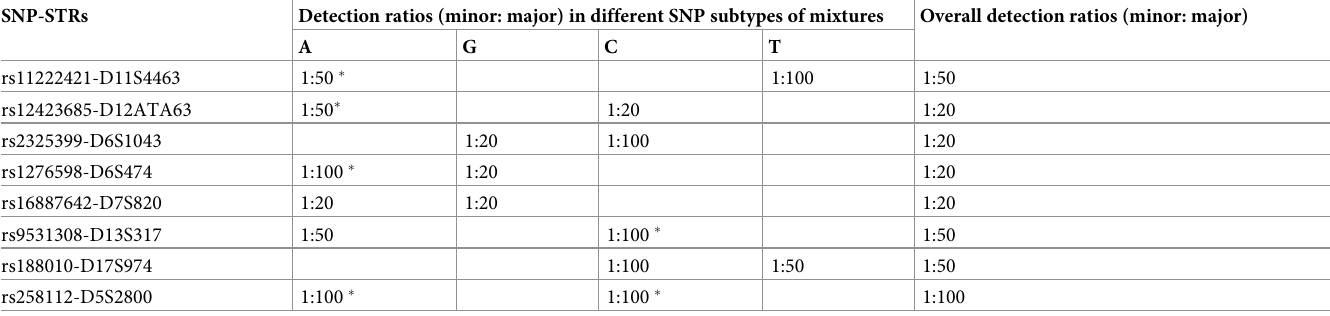
Table 3. The minor DNA detection limit in the artificial DNA mixtures for each marker. SNP-STRs Detection ratios (minor: major) in different SNP subtypes of mixtures Overall detection ratios (minor: